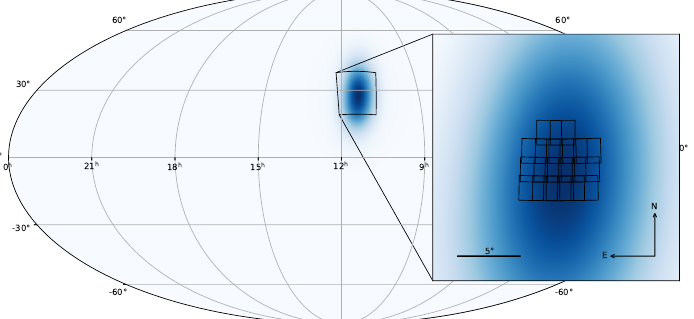
Figure 5. The target of the opportunity observation program produced the observation grids and the observation pointing sequences for GRB 220321A. The trigger number is 669537987, and the probability data from GCN Circular